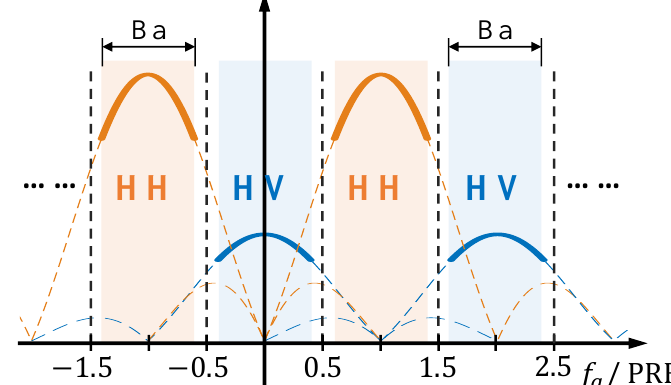
Figure 2. Doppler spectrum of echoes from H polarized receiving channel in hybrid quad-pol SAR mode. The bold solid lines and the dashed lines represent the desired main signals and undesired azimuth ambiguities respectively. Ba is the bandwidth of desired main lobe. PRF is set equal to 1.25 × Ba here; Power of HH polarization is set + 7.9588dB higher than power of HV